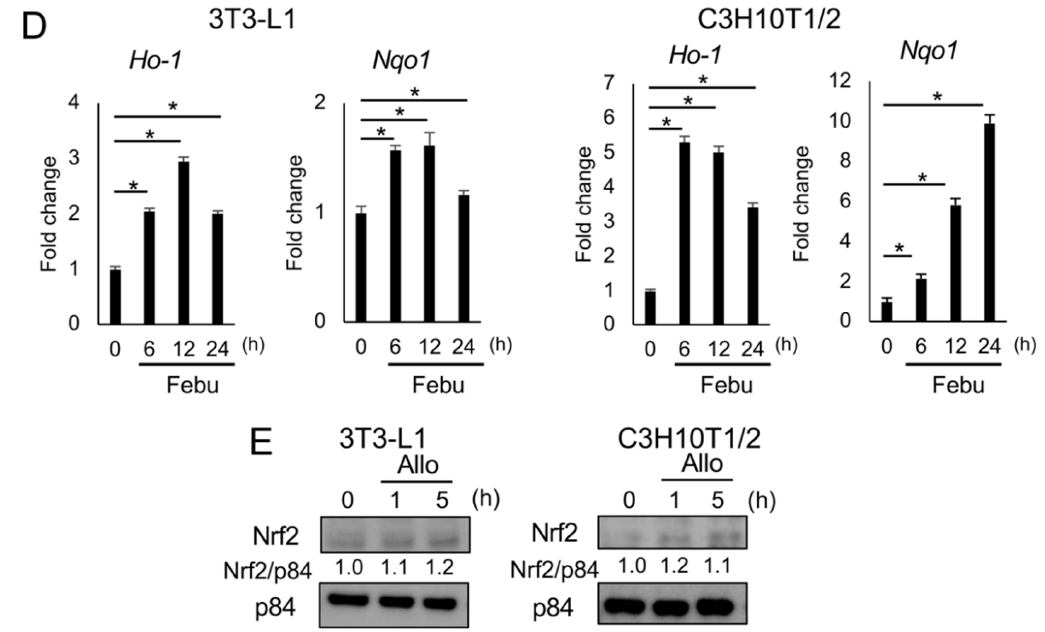
Figure 6. Febuxostat facilitates nuclear translocation of Nrf2. ( A , C ) 3T3-L1 and C3H10T1/2 cells were cultured with Omav or Febu for the indicated time period. Nrf2 levels in the nucleus were analyzed by western blotting. p84 served as a loading control. Relative changes in the band intensities normalized by respective loading controls are indicated. ( B , D ) mRNA expression of Ho-1 and Nqo1 , the target genes of Nrf2, was determined using real-time PCR. Gapdh served as an endogenous control to normalize each sample. Data are expressed as the mean ± SD ( n = 3). * p < 0.05. ( E ) 3T3-L1 and C3H10T1/2 cells were cultured with allopurinol (Allo) for the indicated time period. Nrf2 levels in the nucleus were analyzed by western blotting, and p84 served as a loading control. Relative changes in the band intensities normalized by respective loading controls are indicated.